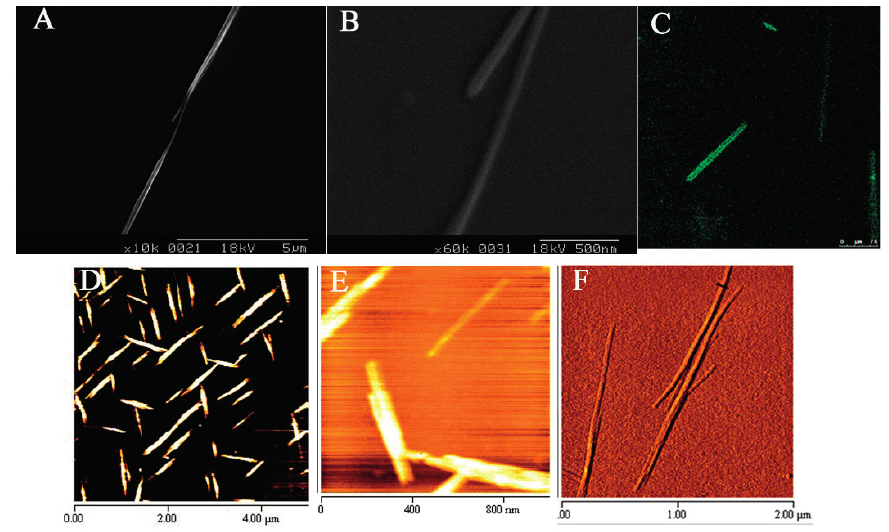
Figure 1. Morphology of cyclo -( D -Trp-Tyr) peptide nanotubes (PNTs). Images from scanning electron microscopy (SEM) ( A , B ), atomic force microscopy (AFM) ( D – F ) and staining with thioflavin T by fluorescent microscopy are presented ( C ).